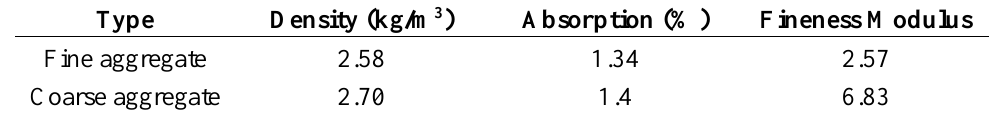
Table 5. Physical properties of aggregates.